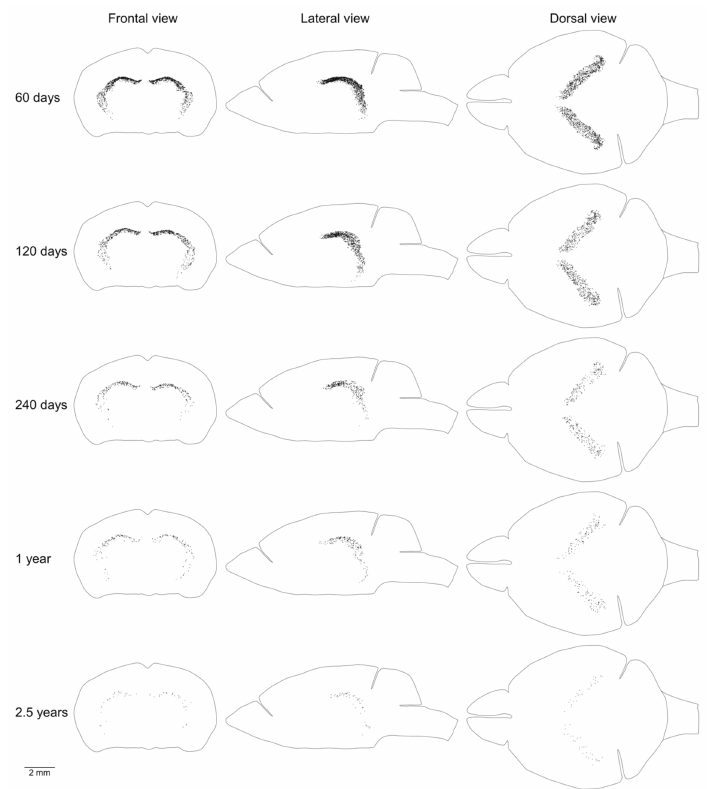
Figure 4. Distribution of proliferating cells in the subgranular zone (SGZ). Each EdU-labeled nucleus is shown as a black dot. The scale is shown at the bottom. The brain shape is outlined with a black line. Frontal, lateral, and dorsal views of the brain are shown. Mouse age is shown on the left.